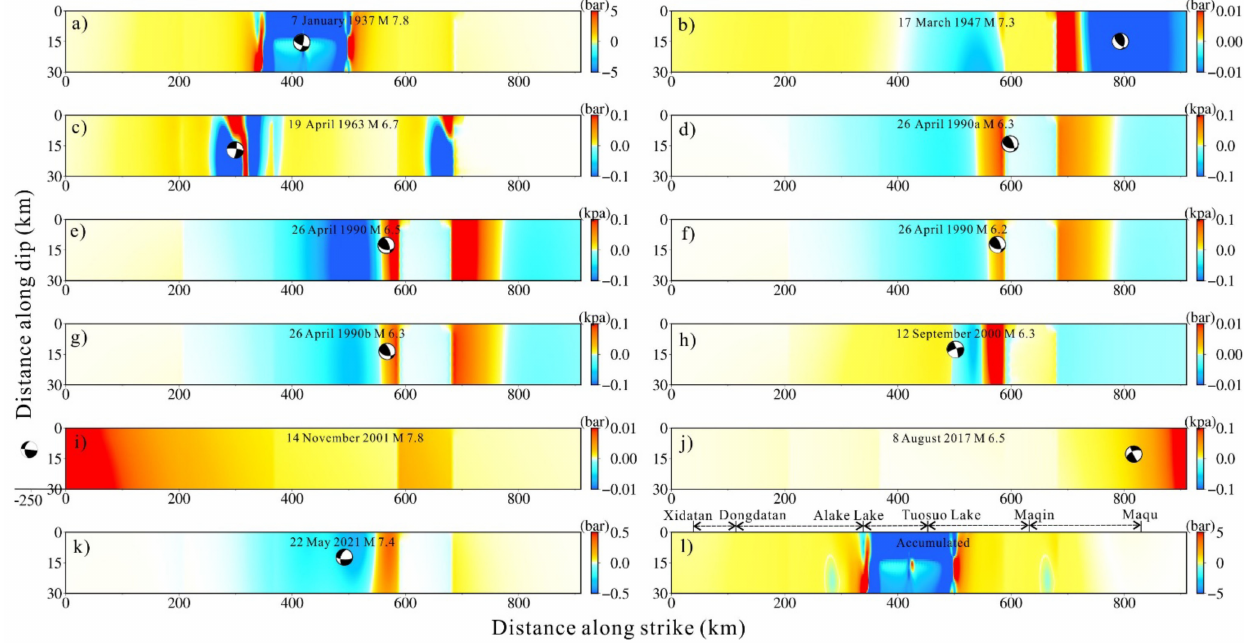
Figure 13. The Coulomb failure change on the Kunlun fault caused by the historical earthquakes including the 1937 M 7.8 ( a ), 1947 M 7.3 ( b ), 1963 M 6.7 ( c ), 1990a M 6.3 ( d ), 1990 M 6.5 ( e ), 1990 M 6.2 ( f ), 1990b M 6.3 ( g ), 2000 M 6.3 ( h ), 2001 M 7.8 ( i ), 2017 M 6.5 ( j ) and the 2021 Maduo earthquake ( k ). ( l ) The accumulated CFS change on the Kunlun fault by the historical earthquakes. It should be noted that the color bar of each sub-figure is chosen based on the CFS change magnitude. The strike angle of the receiver fault was set based on the strike of each segment of the Kunlun fault, and the dip angle and rake angle were set as 77 ◦ and 0 ◦ based on the historical earthquakes that occurred along the Kunlun